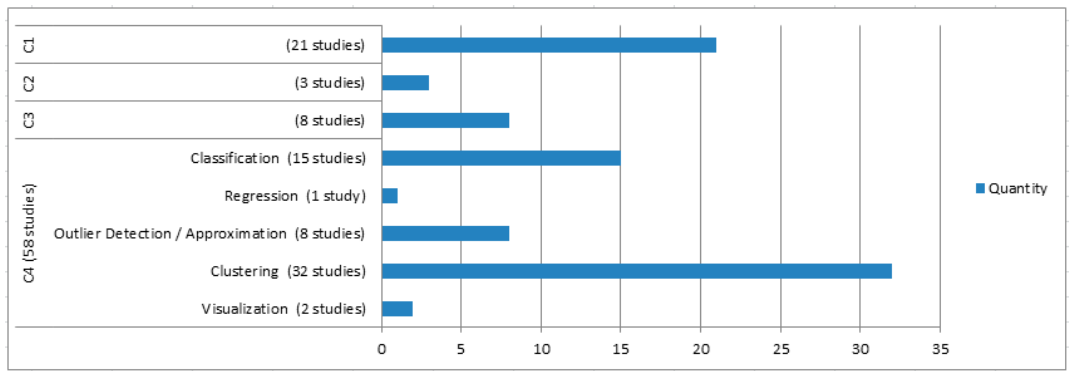
Figure 5. Quantitative distribution of studies by support mechanism category and application class.